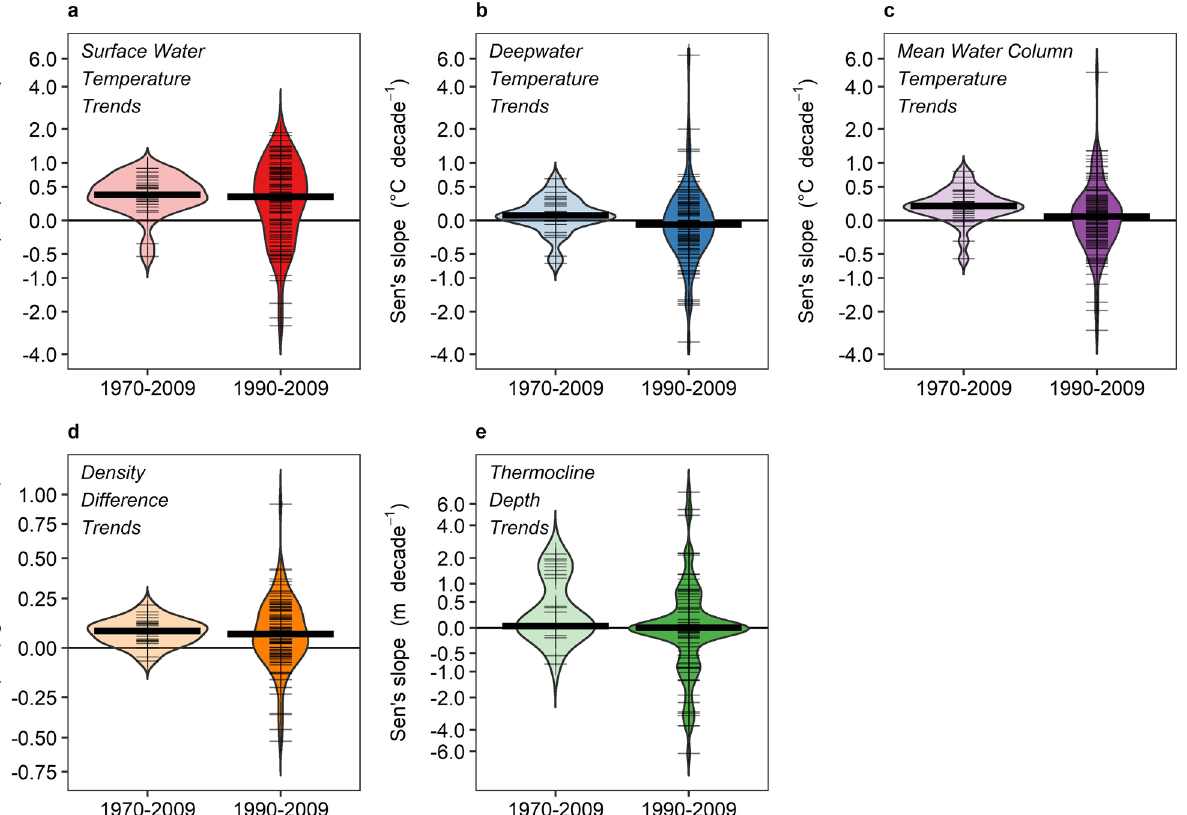
Figure 2. Distribution of trends in thermal metrics across lakes. Paired violin plots of temporal trends in five lake thermal metrics from 1970–2009 (left of each panel) and from 1990–2009 (right of each panel): ( a ) surface water temperature, ( b ) deepwater temperature, ( c ) mean water column temperature, ( d ) density difference, and ( e ) thermocline depth. Note that y -axes are log-transformed based on the transformation in Eq. (2). Thick horizontal line indicates the median for the respective time period, and thin tick marks indicate trends for individual lakes. Panels ( a – c ) are all on the same y -axis